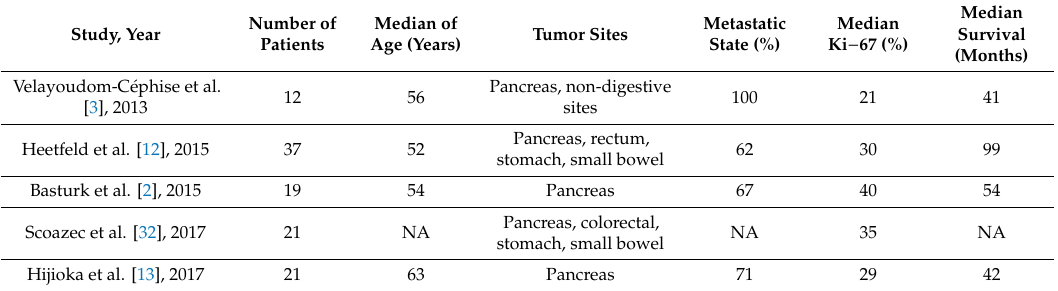
Table 2. Main studies evaluating clinical and pathologic characteristics of patients with NET G −